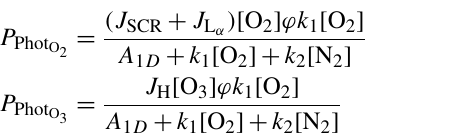
Table A1. In the following, [·] corresponds to the number densities of molecules. The loss component can be calculated